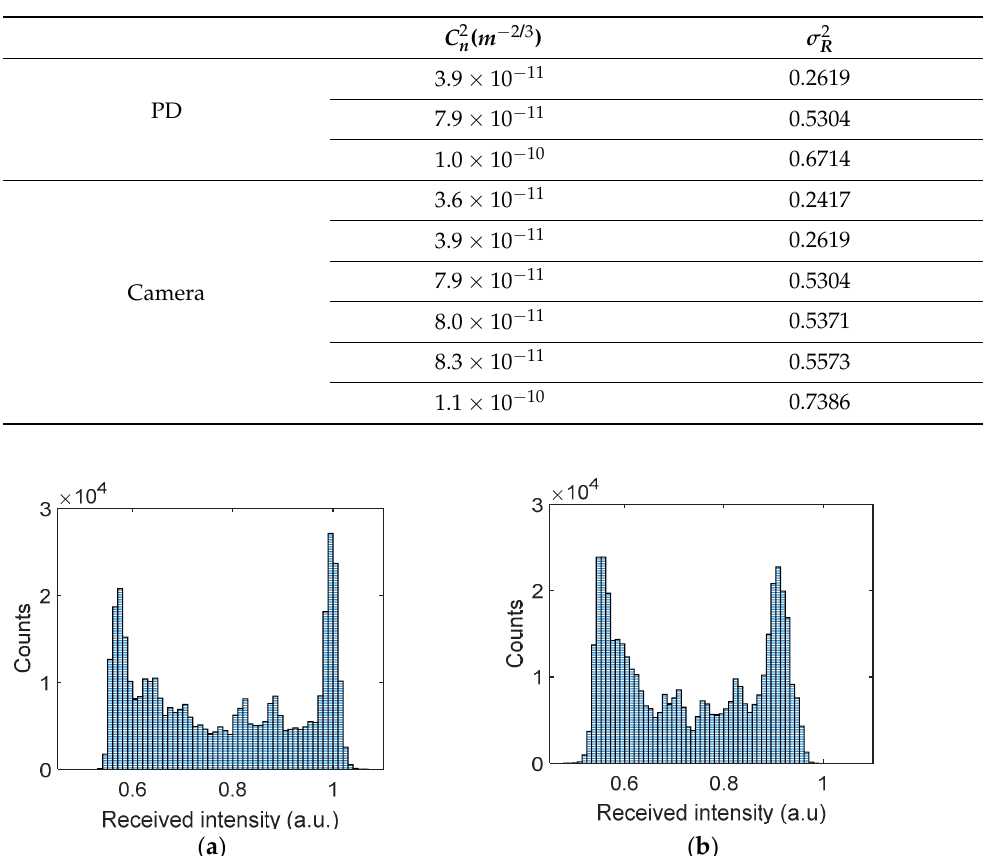
Table 3. σ 2 for corresponding C 2 n values measured in the experiments. R